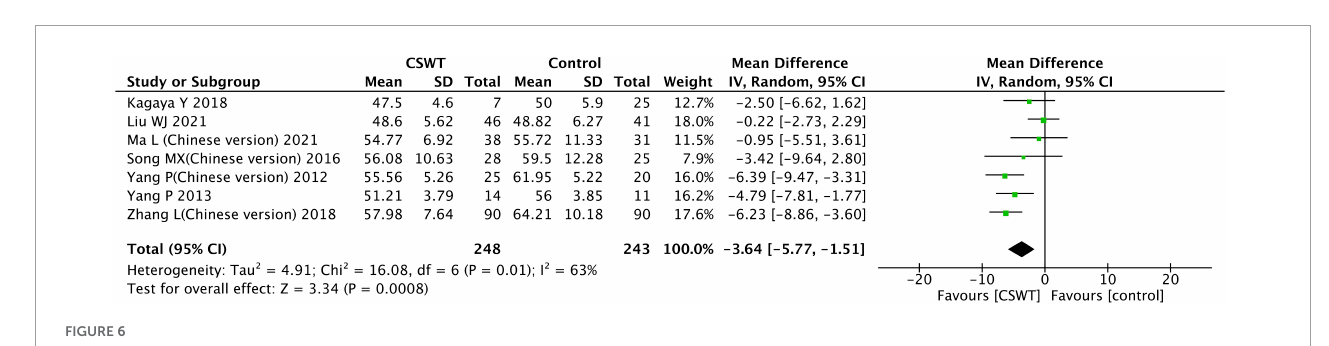
FIGURE6 Forest plot of the CSWT group vs. the control group-LVEDD.